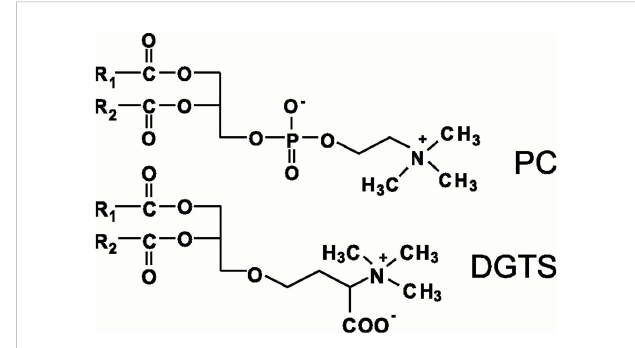
FIGURE 1 Structures of PC and DGTS. Figure reproduced with permission from Klug and Benning, 2001. Copyright (2001) National Academy of Sciences, U.S.A. DGTS, diacylglyceryl-N,N,N-trimethylhomoserine; PC,